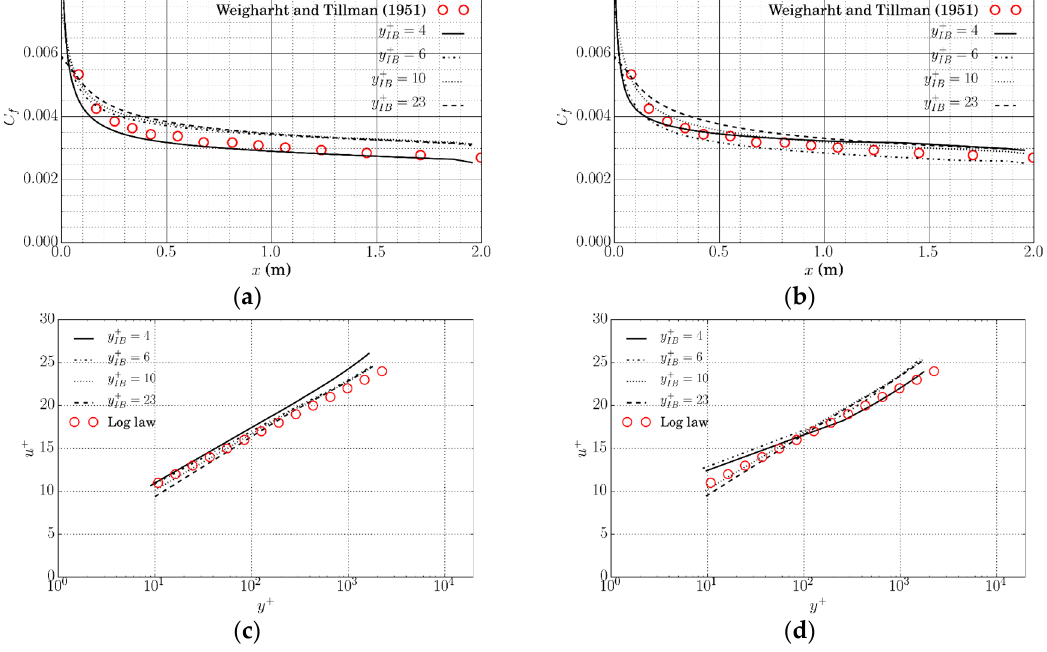
(cid:2025)(cid:1847) (cid:2870) (cid:3415) ) and velocity profile at ρ U 2 ) and velocity profile (cid:2870) 2